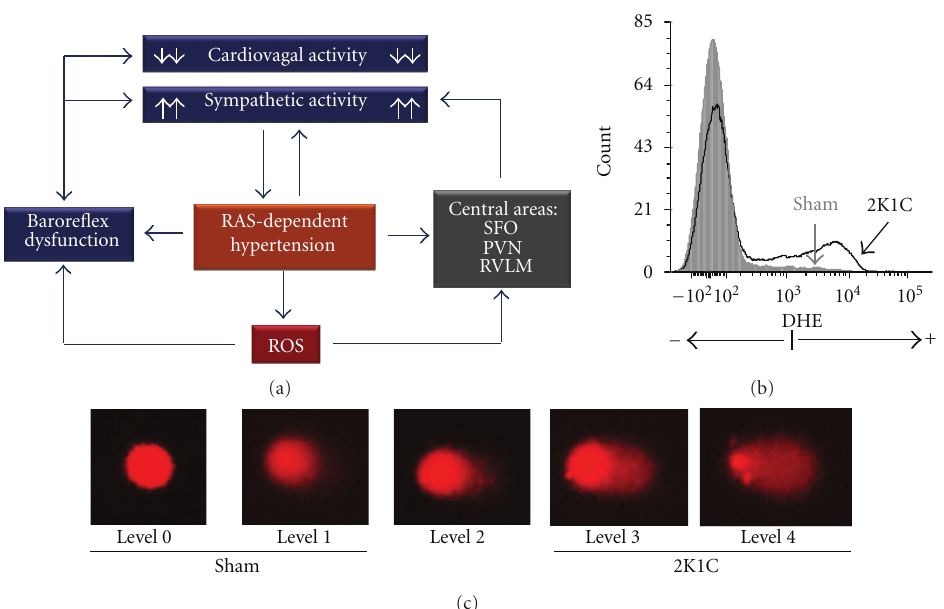
Figure 5: Relationship between RAS activation, ROS production, and baroreflex dysfunction in the 2K1C mouse. (a) E ff ects of renal clipping-induced high plasma levels of angiotensin II on peripheral and central neural areas controlling cardiovascular function mediated by reactive oxygen species (ROS); (b) typical flow cytometric analysis with the dihydroethidium assay (DHE) showing elevated production of superoxide in 2K1C mice; (c) comet assay illustrating the detection of greater levels of DNA damage (comet-tail fragmentation) in the 2K1C